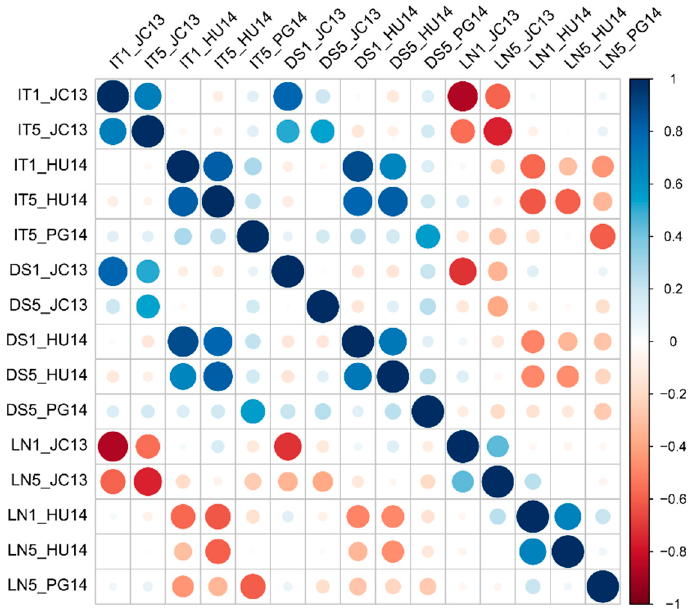
Figure 1. Pearson correlations between the disease parameters scored at the seedling stage: infection type (IT), disease severity (DS), and leaf necrosis (LN), for each leaf rust isolate: Jerez Califa 13 (JC13), Huesca 14 (HU14), and Peralta García 14 (PG14). The numbers 1 or 5 after the disease parameter indicate the first and fifth leaf, respectively. Coefficients > |0.18| are significant ( p < 0.05).